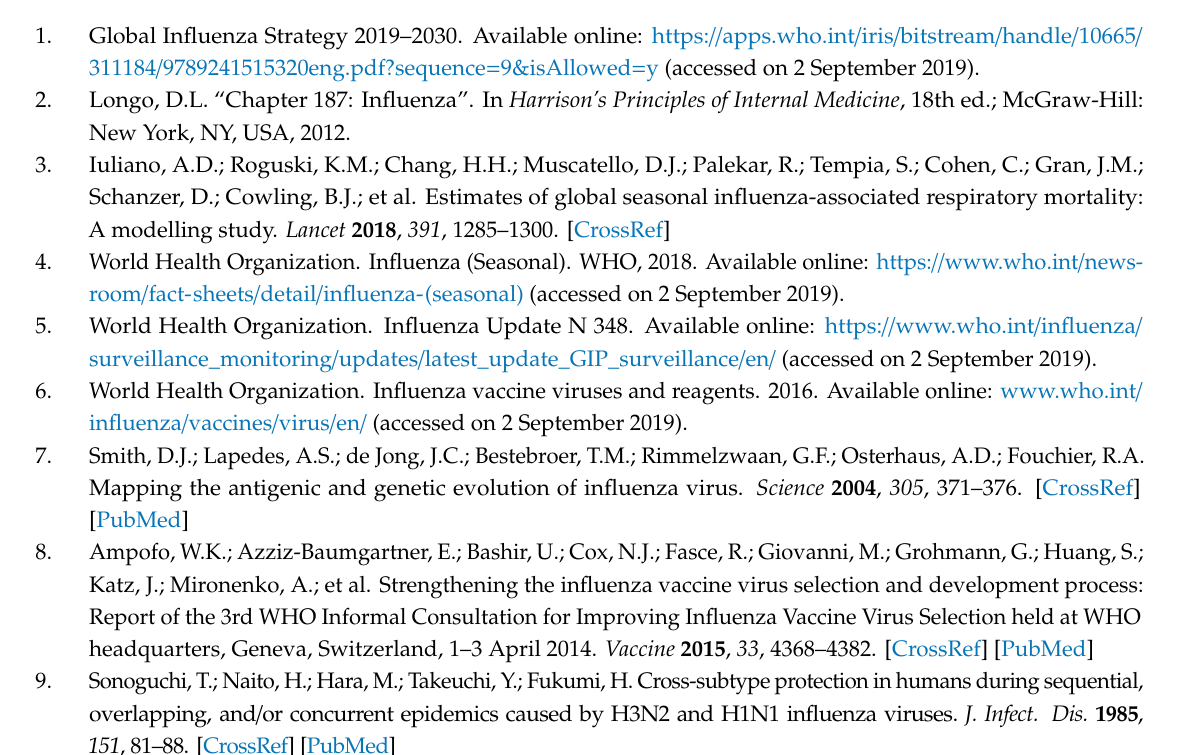
Figure S1: Temporal distribution of the weekly incidence proxies for influenza A / H1N1 from 2010 to 2019. Figure S2: Temporal distribution of the weekly incidence proxies for influenza B from 2010 to 2019.Figure S3: Residual standard error for various combinations for thresholds h and h c . Table S1: Summary of the prediction timing of week s and the epidemic peak weeks of influenza A / H1N1, A / H3N2, and